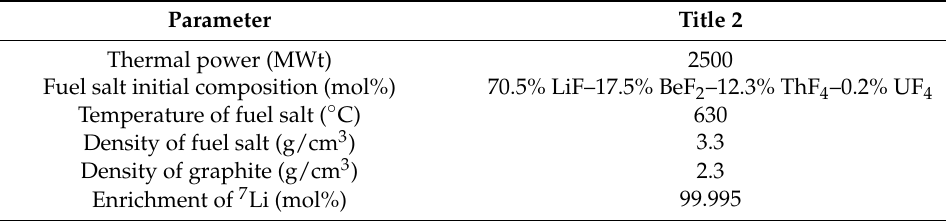
Figure 2. Structural diagram of the MSBR core [22]. Table 1. Summary of the characteristics of the MSBR.